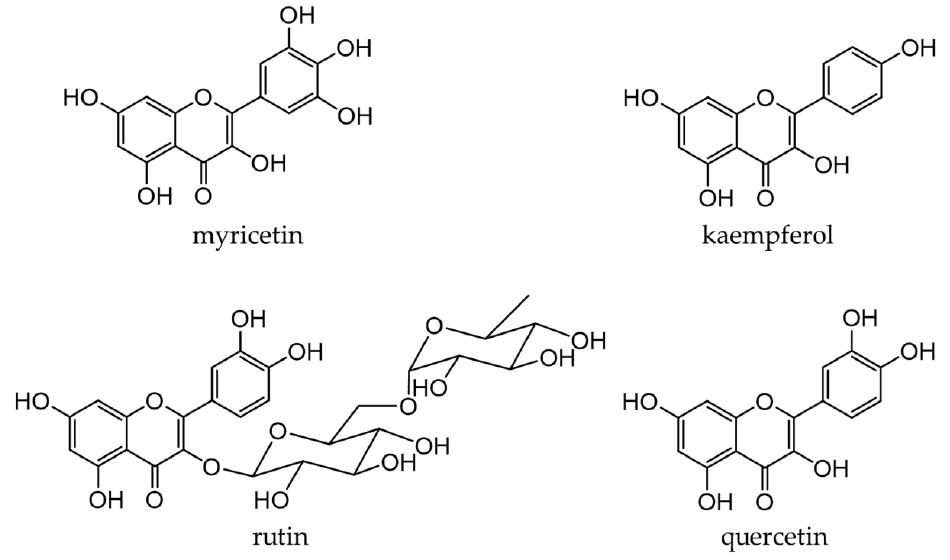
Figure 6. Chemical structures of major flavonols.